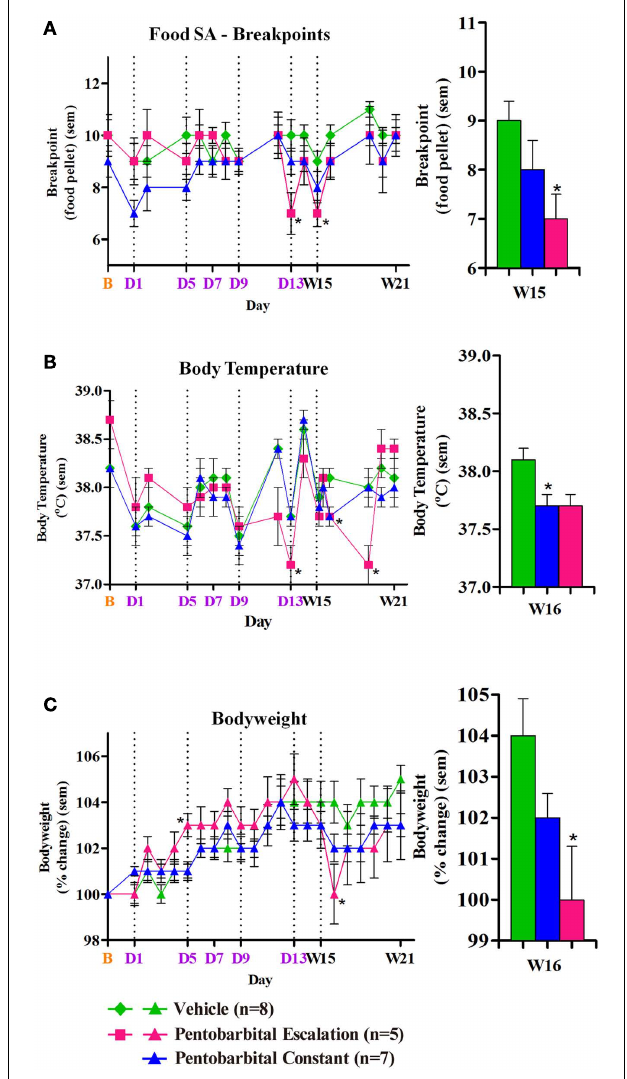
FIGURE 3 | (A–C) . Food self administration break point reached, body temperature, and body weight following chronic pentobarbital or vehicle B=baseline, D=dosing,W=withdrawal, *= p ≤ 0.05 compared to vehicle, dotted line = anesthesia for pump loading. Points represent mean ±